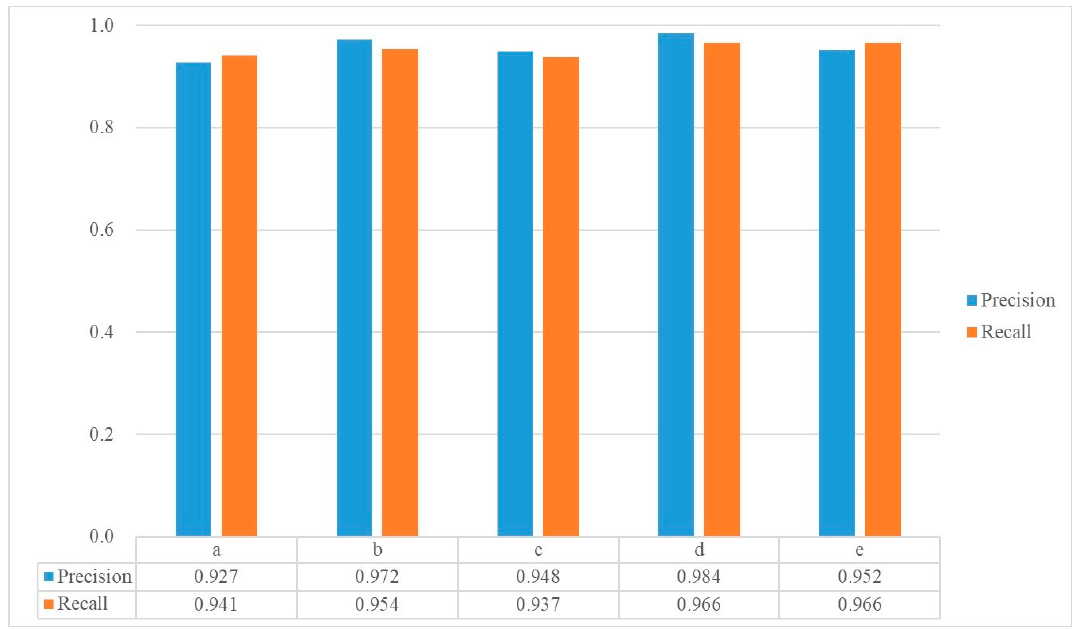
Figure 10. Results of average of precision, and recall for each sitting posture.